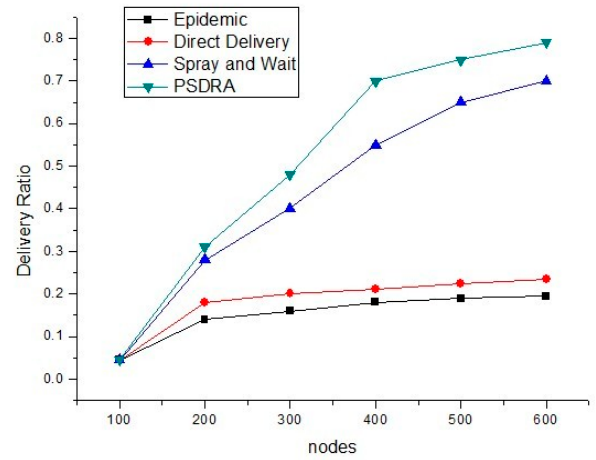
Figure 2. The delivery ratio with algorithm.